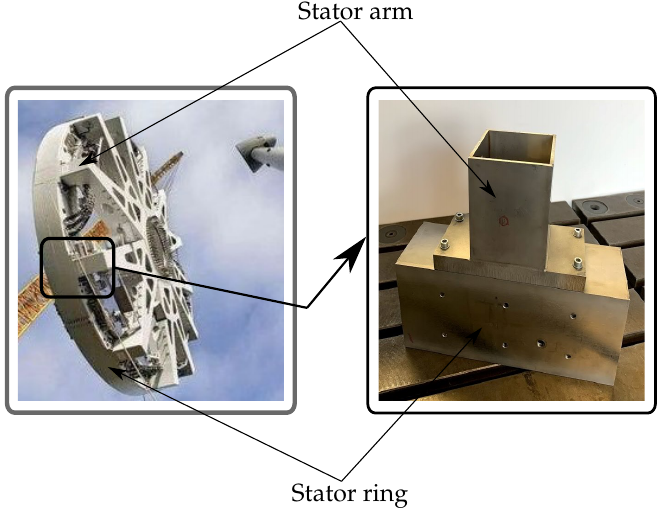
Figure 1. Left: Assembly of a stator of a 7.5MW commercial wind turbine [40]. Right: Scaled wind Figure 1. ( Left ): Assembly of a stator of a 7.5 MW commercial wind turbine [39]. ( Right ): Scaled turbine stator test specimen for laboratory purpose. wind turbine stator test specimen for laboratory purpose. Appl. Sci. 2022 , 1 , 0